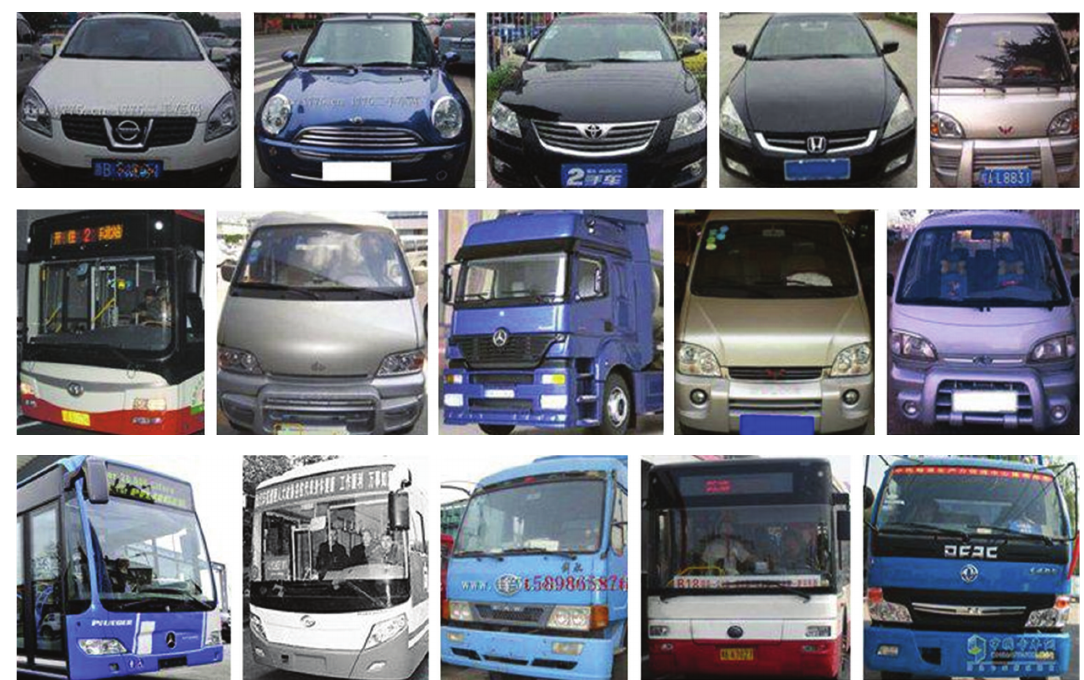
Figure 3: Examples of vehicle images as the positive